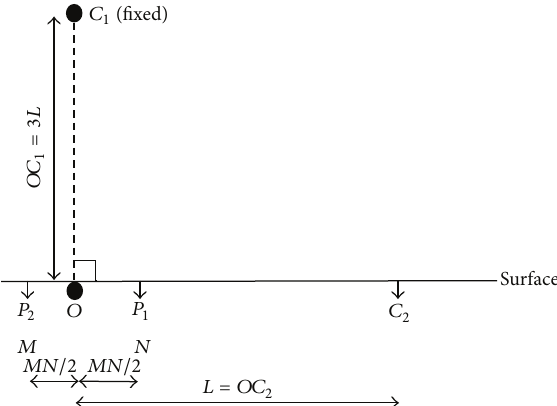
Figure 3: Diagrammatic representation of the electrode configuration in Hummel method (modified Schlumberger array). Note that when the distance 𝑂𝐶 1 = 𝑂𝐶 2 = 𝐿 , we have the “Half-Hummel”